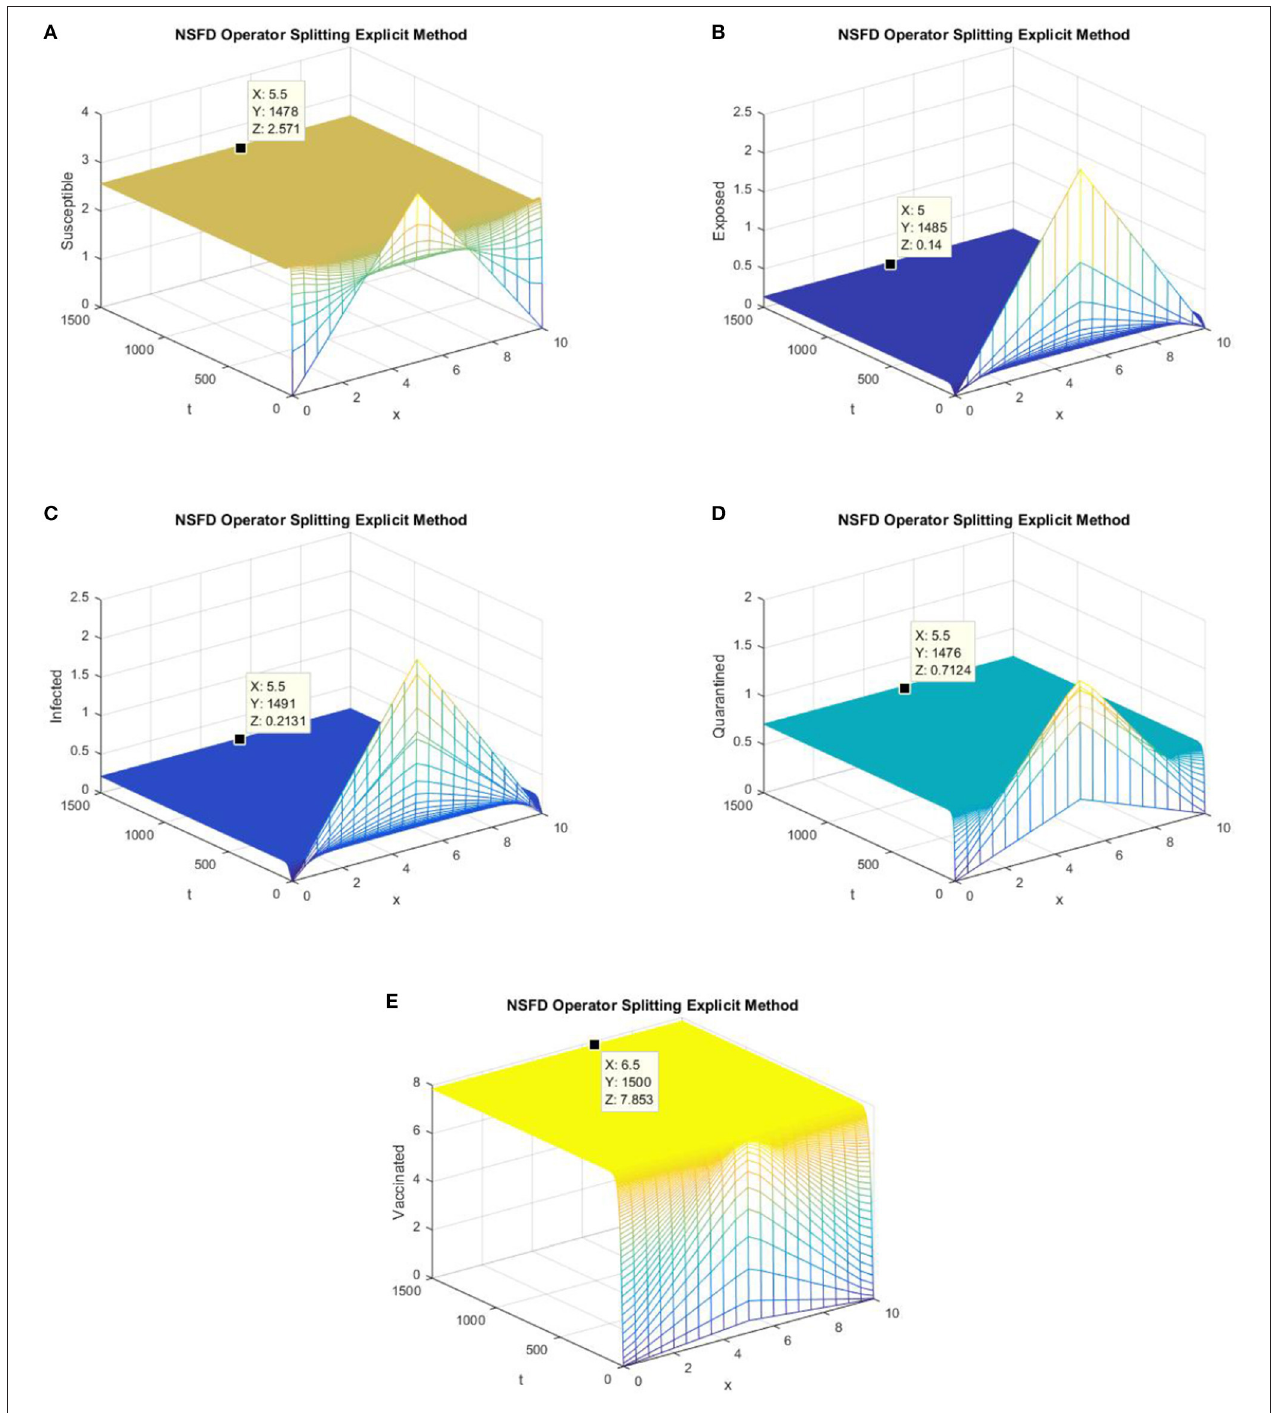
FIGURE 5 | (A) The explicit operator splitting NSFD scheme is used to simulate graphs (A–E) . (A) Mesh graph of S ; (B) Mesh graph of E ; (C) Mesh graph of I ; (D) Mesh graph of Q ; (E) Mesh graph of V .